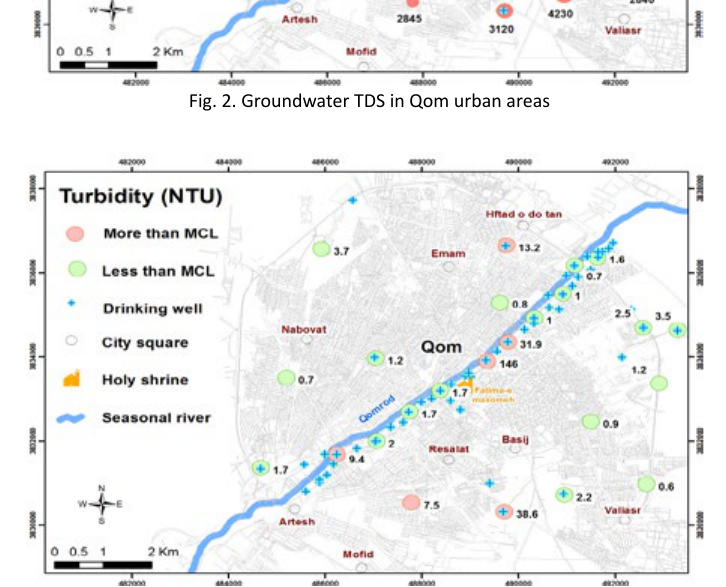
Fig. 2. Groundwater TDS in Qom urban areas Fig. 3: Groundwater turbidity in Qom urban areas.